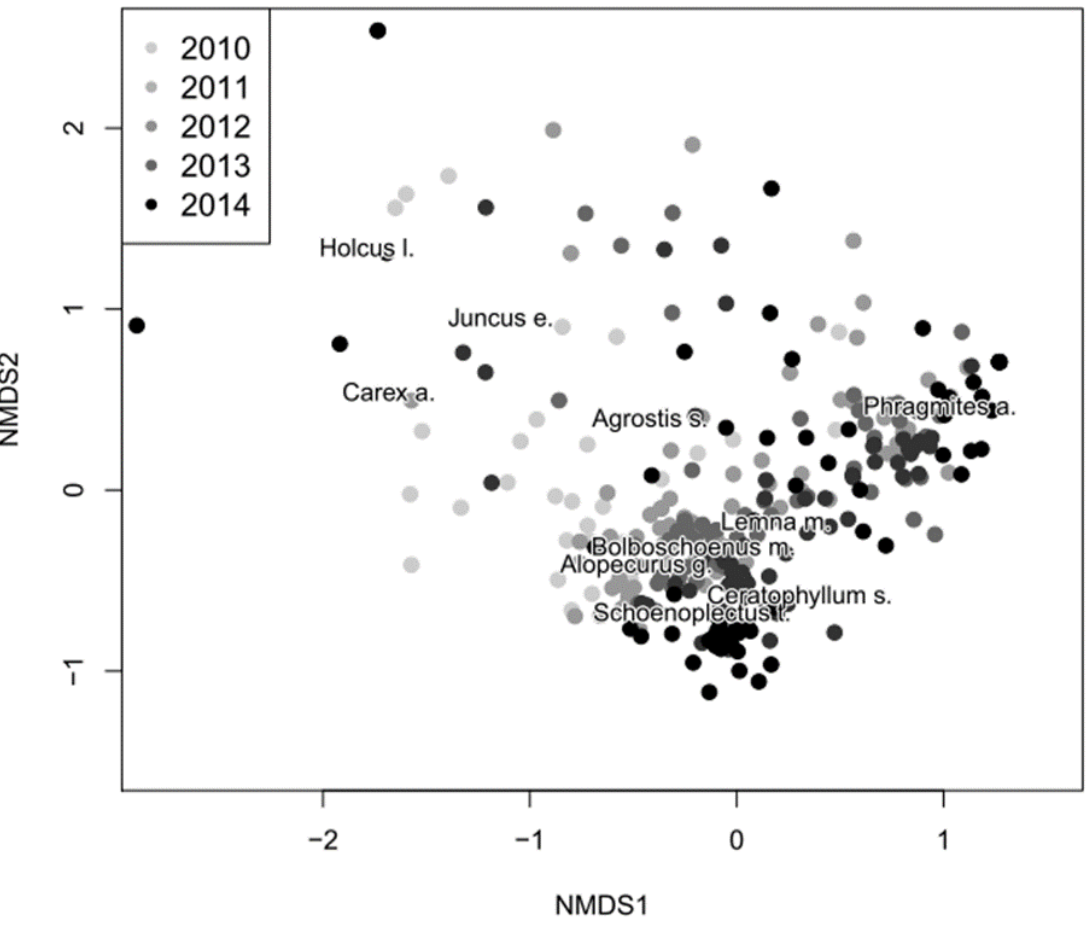
Figure 4. NMDS-ordination (stress 0.17) based on Bray-Curtis dissimilarities of vegetation records from 2010 to 2014.